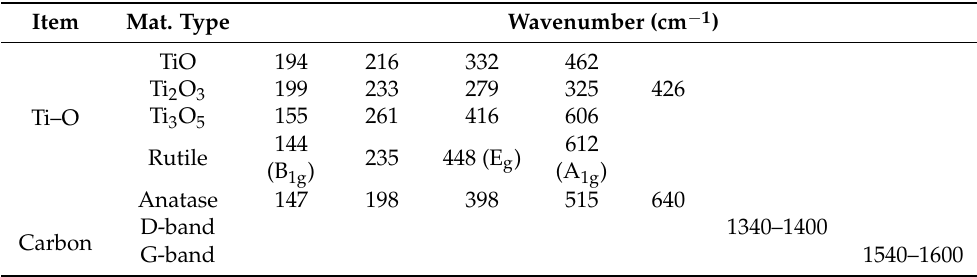
Figure 1. Raman spectra of C-free and C-doped Ti–O films, sample No. are marked in the figure and 304 represents the stainless steel substrate. Table 2. The standard Raman shifts of carbon and Ti–O compounds.